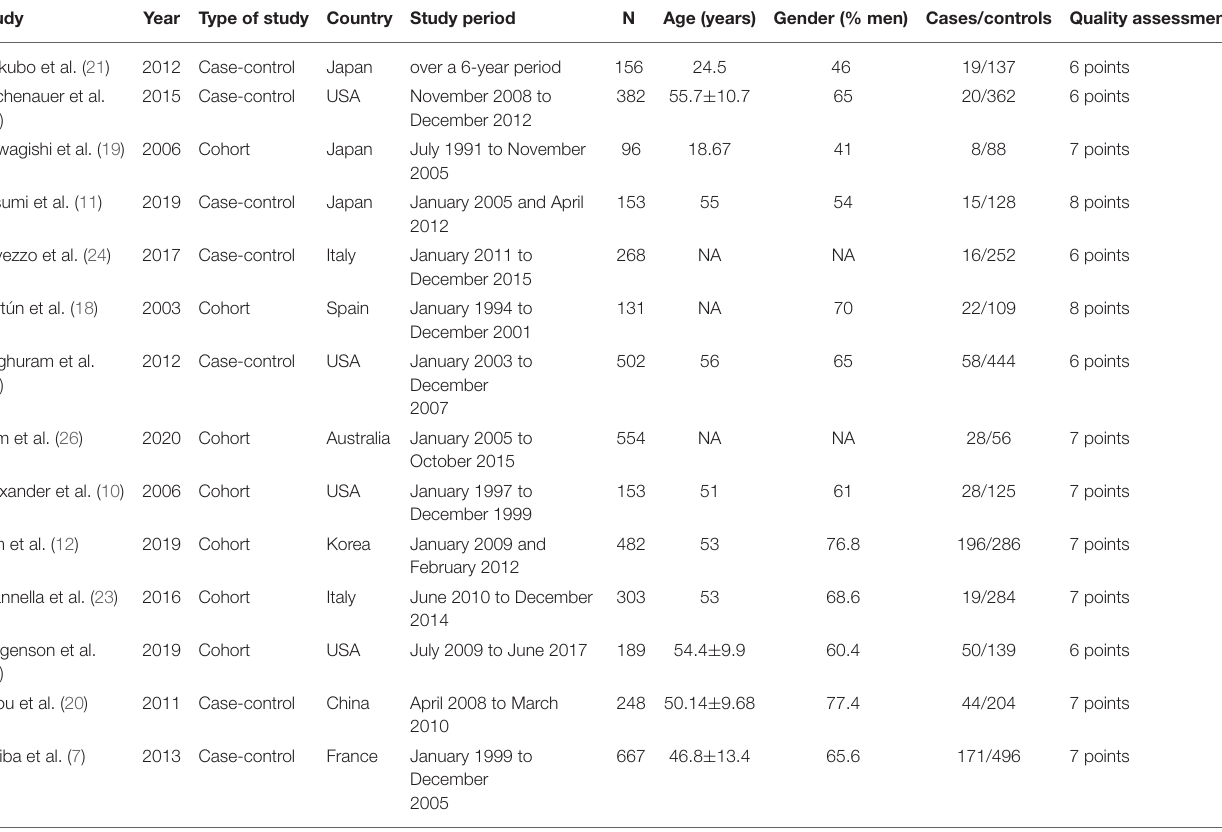
TABLE 1 | Characteristics of studies included in the meta-analysis.